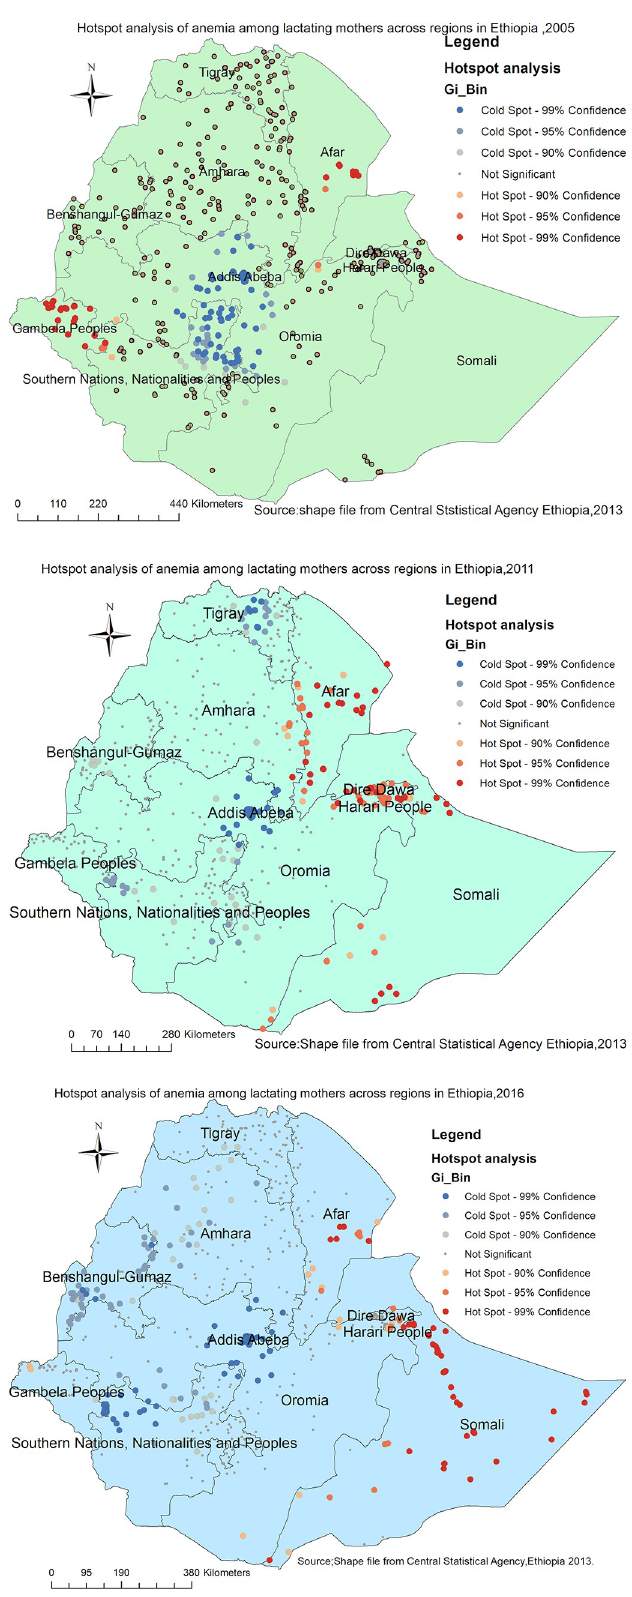
Fig 6. a-c: Hot spot identification of anemia among lactating mothers in Ethiopia 2005 (a), 2011 (b), 2016 (c) EDHS (Source: Shapefile from Central Statistical Agency, Ethiopia, 2013). https://doi.org/10.1371/journal.pone.0237147.g006 PLOS ONE | https://doi.org/10.1371/journal.pone.0237147 August 6,